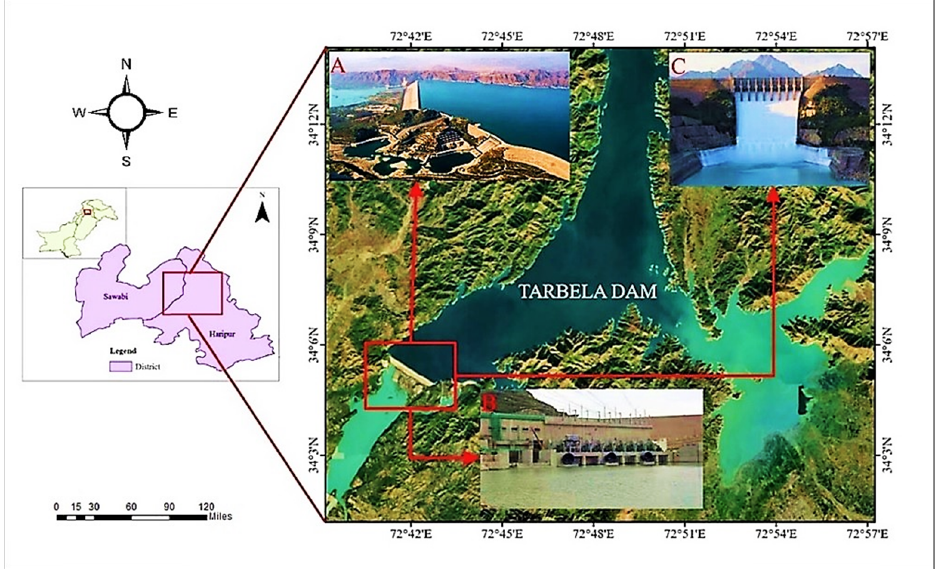
Figure 1. Satellite image of Tarbela Dam site used for this study. ( A ) Tarbela dam satellite overview, ( B ) Tarbela power house, ( C ) Tarbela dam main abutment.